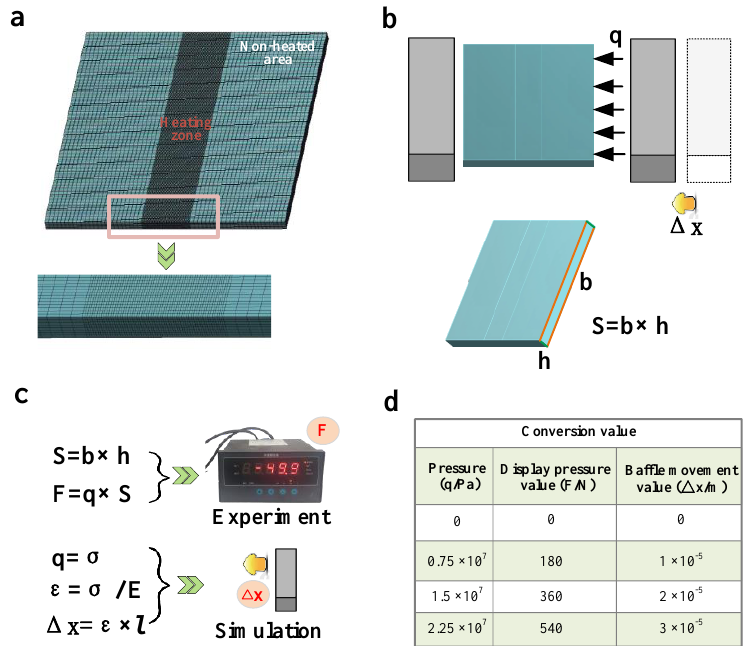
Figure 3. Schematic diagram of meshing, functional relationship between force and displacement. ( a ) Schematic diagram of the grid division, ( b ) schematic diagram of the action of the baffle, ( c ) equation of the relationship between force and x-directional displacement and ( d ) specific values of force and x-directional displacement.